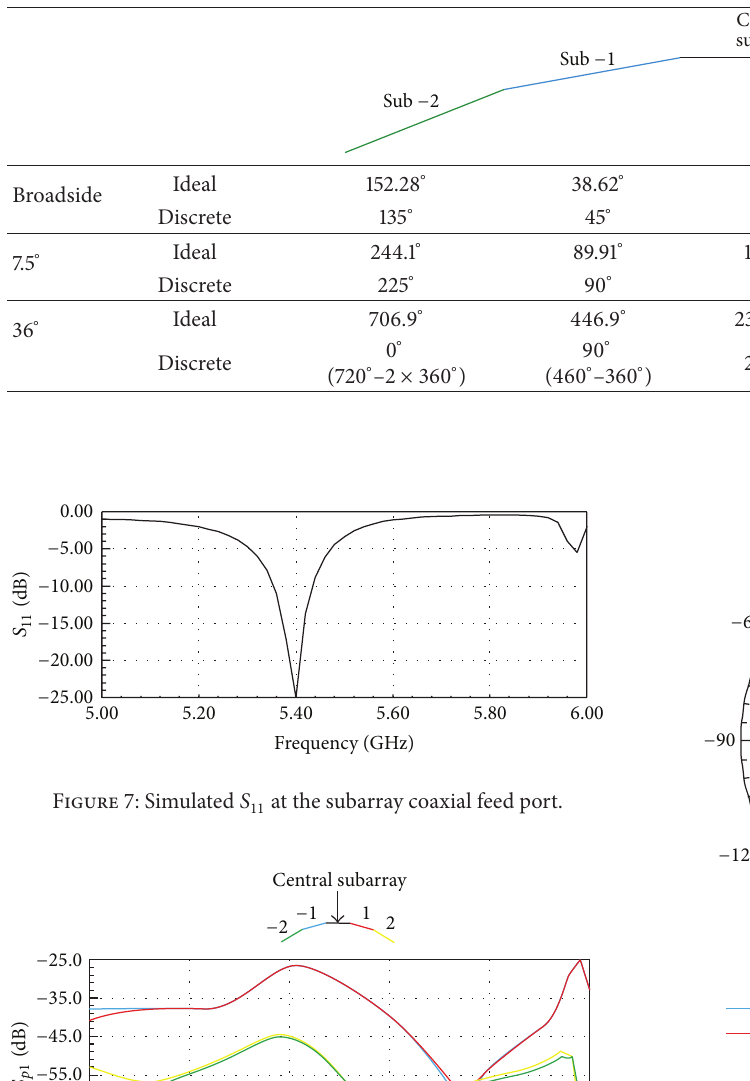
Table 1: Phase shifts for beam steering.